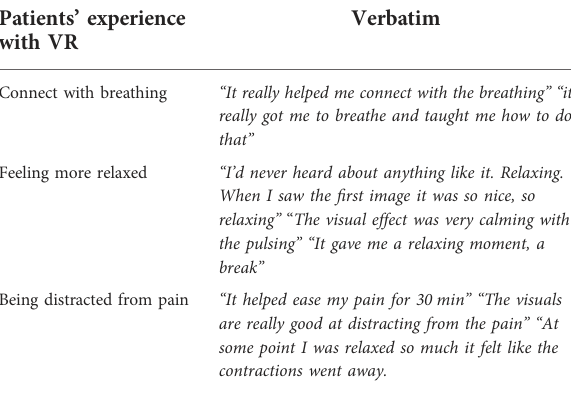
TABLE 1 Patients ’ experience of VR during labor – thematic analysis. Patients ’ experience